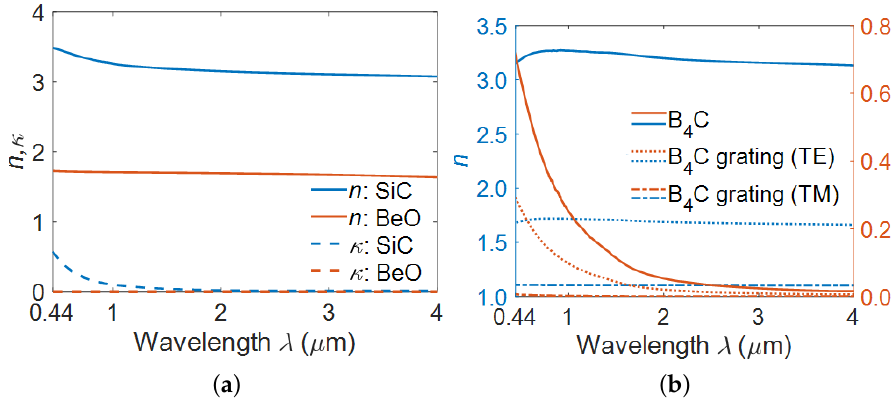
Figure 2. ( a ) Refractive indices ( n ) and extinction coefficients ( κ ) of SiC and BeO. ( b ) Refractive indices ( n ) and extinction coefficients ( κ ) of B 4 C and B 4 C grating with filling ratio of 0.2, including TE and TM